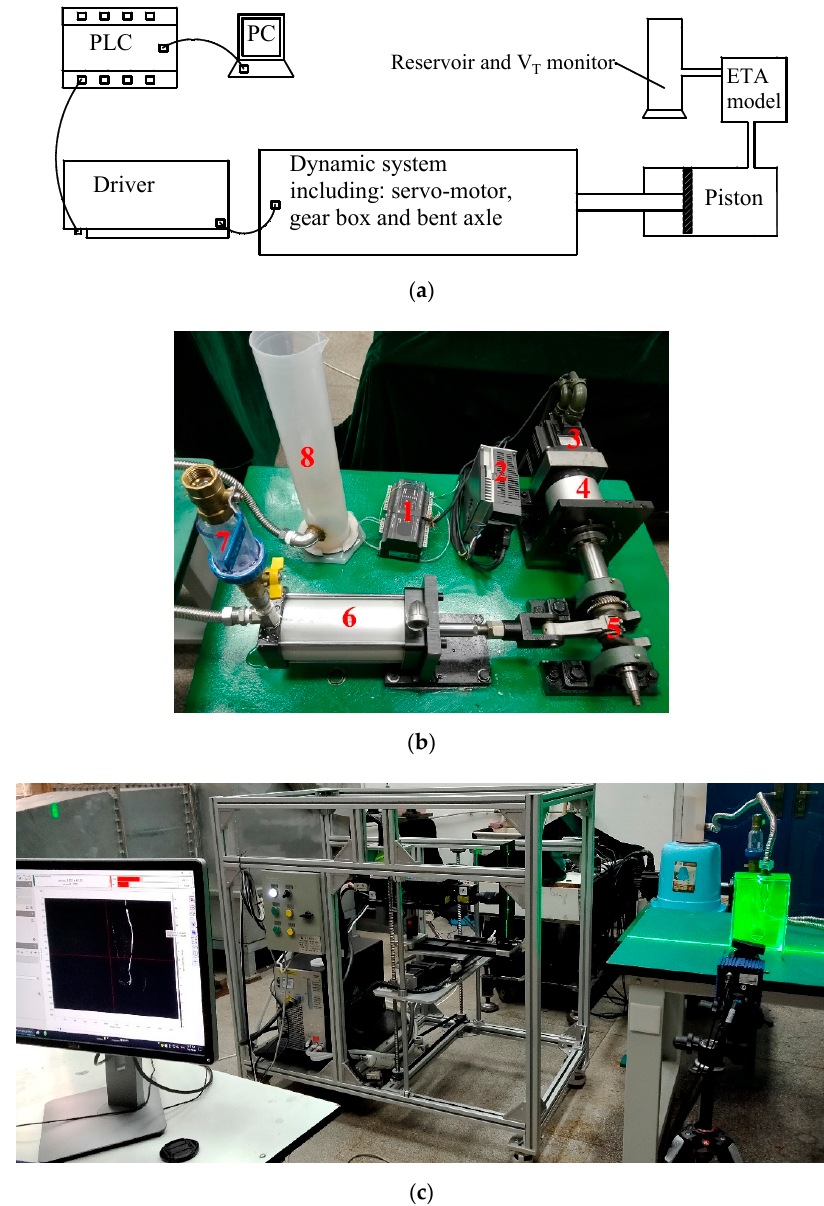
Figure 5. Experimental rig: ( a ) schematic; ( b ) main apparatus (except ETA tract and PIV system):1 PLC; 2 driver; 3 servo-motor; 4 gear box; 5 bent axle; 6 piston; 7 air exhausting device; 8 reservoir and V T monitor; ( c ) photo of experimental rig.